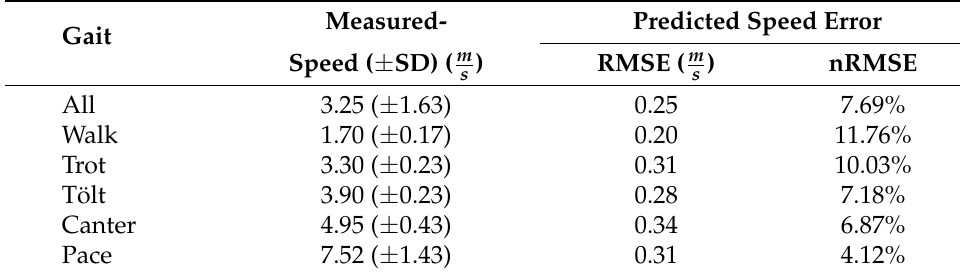
Table 5. Performance of model (based on “All” feature set and Random forest method) per gait